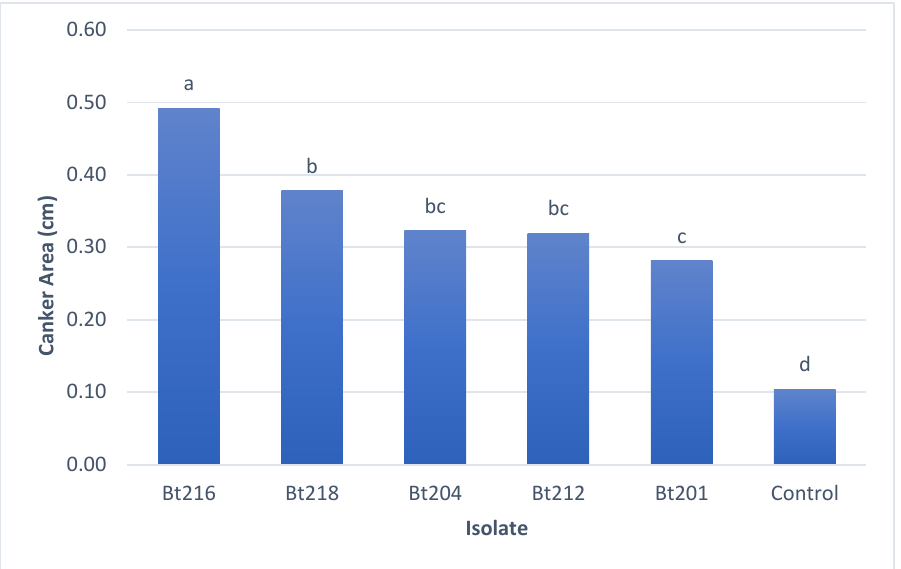
Figure 3. Mean canker areas (cm) in green stem caused by artificial inoculation with Botryosphaeriaceae isolates under study. Different letters in column correspond to significant differences ( P < 0.05) based on ranks assessed by Kruskal-Wallis analysis. Ten plants were used per isolate while control plants were sprayed with sterile distilled water.